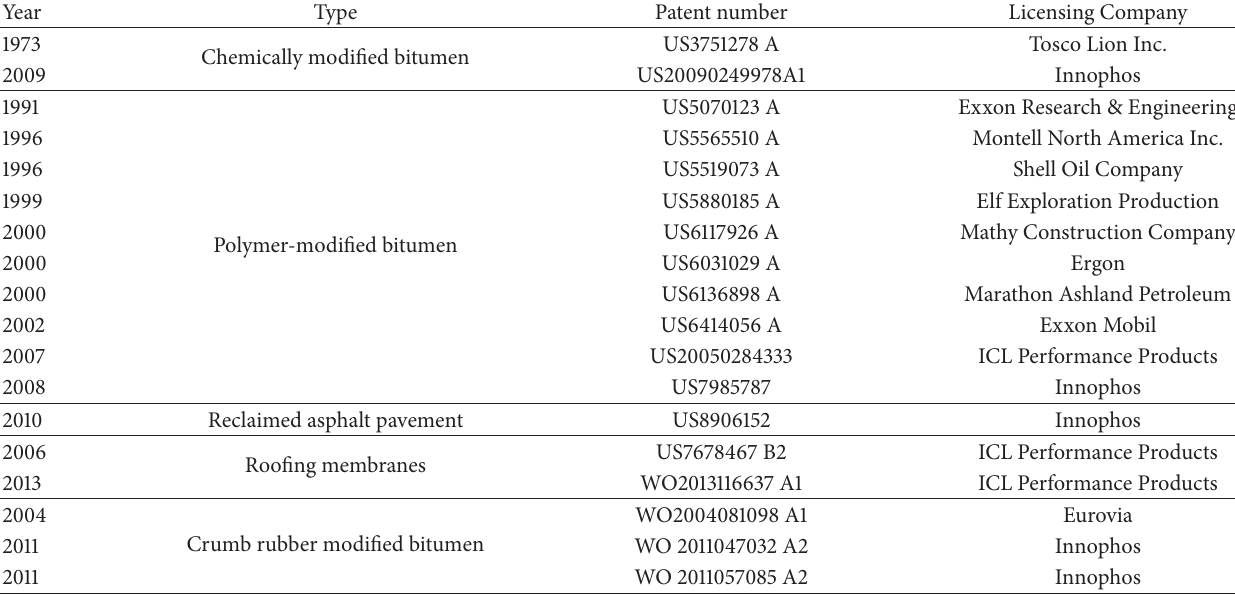
Table 6: Summary of issued patents related to bitumen modification with